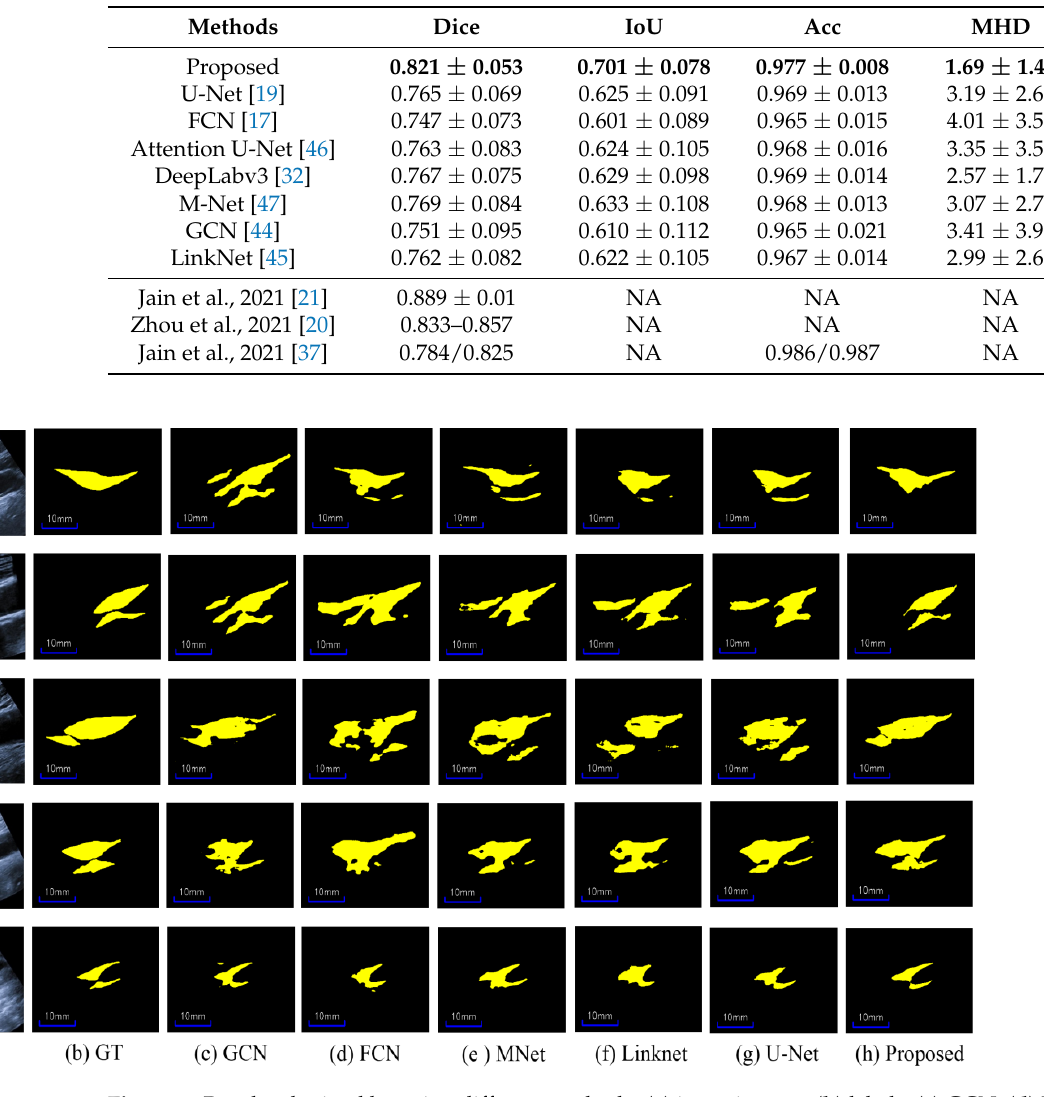
Figure 8. The total plaque areas’ distribution for 40 patients with severe stenotic plaques. To illustrate if there exist significant differences between two methods on the two popular metrics, Dice and MHD, we performed a paired t -test to compare the results of each baseline method with those of our method. The computed p -values are shown in Table 3. As can be found, all p -values are less than 0.05, suggesting that our results are significantly different from the results of other baseline methods; each improvement is statistically significant.